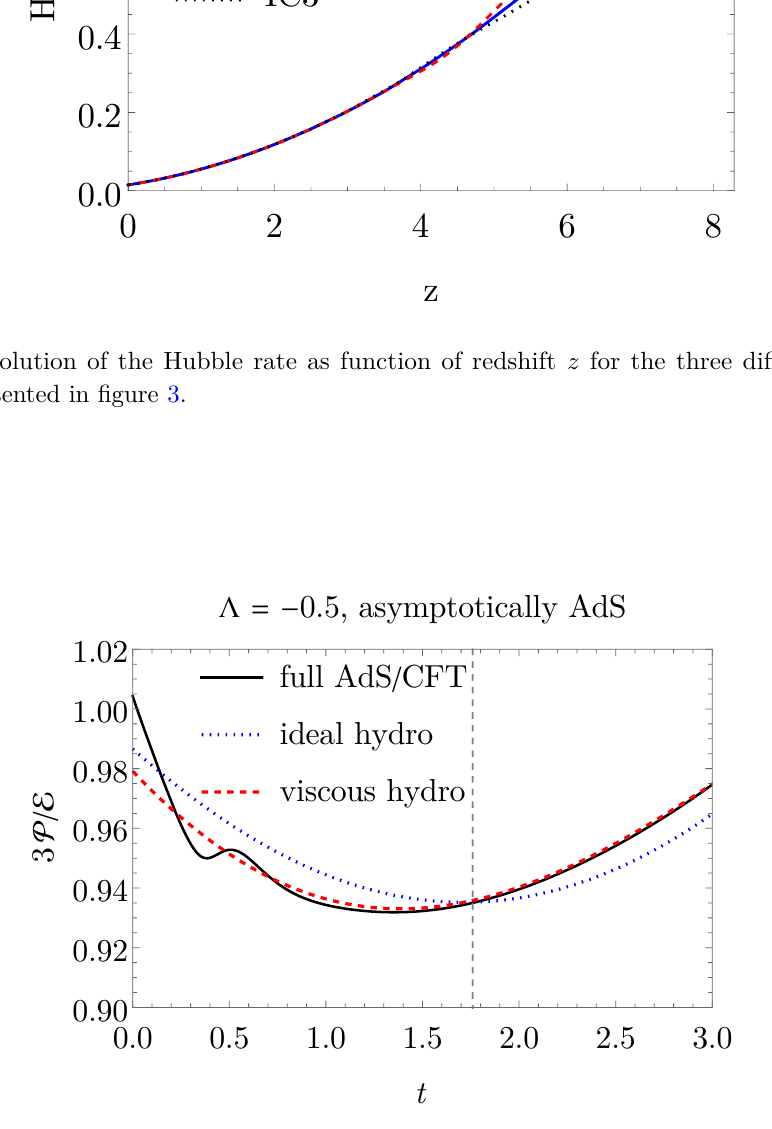
Figure 5 . Comparison between the holographic result for the pressure/energy ratio (black) and the ideal (blue) and viscous (red) approximations, for G = 1 / 2500 and Λ = − 0 . 5